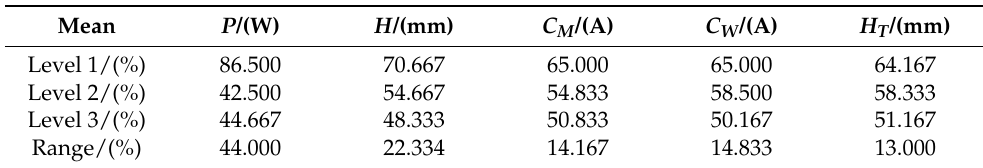
Table 2. Results of the orthogonal experimental analysis of ∆ L 1 .